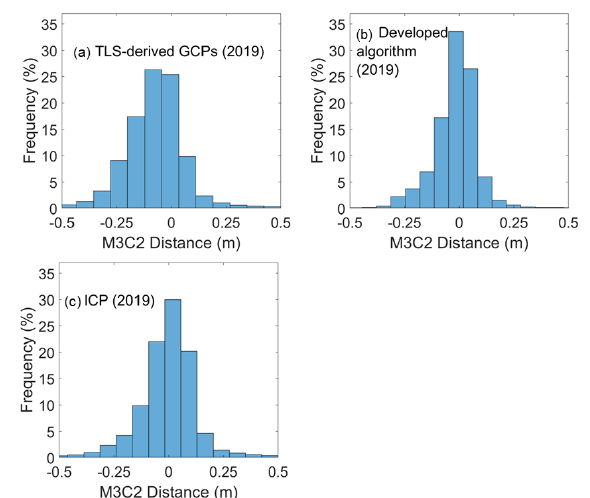
Figure 9. Histograms for TLS (2018) and TP (2019) comparisons; 2019) comparison (a) initial registration using TLS-derived GCPs; (b) Registration using the developed algorithm; (c) Registration using the ICP algorithm.